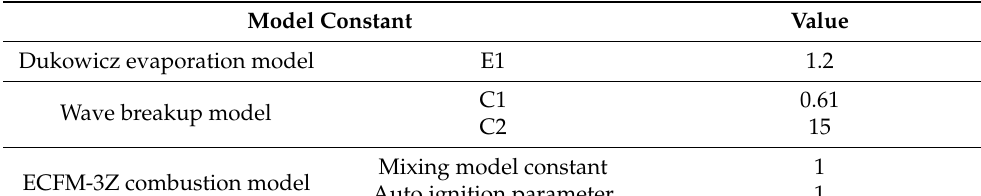
Table 3. Some parameters of submodels settled in AVL ESE DIESEL.